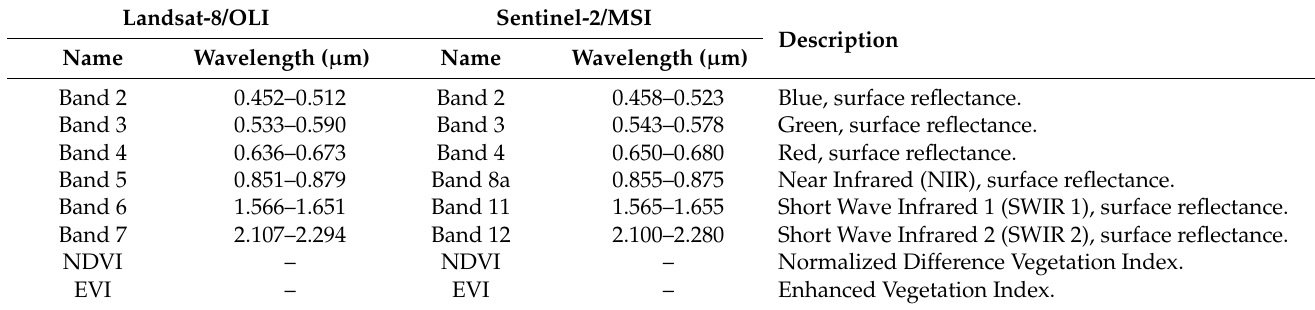
Table 2. Landsat-8/OLI and Sentinel-2/MSI time series data used as input t LSTM. Source: [60].